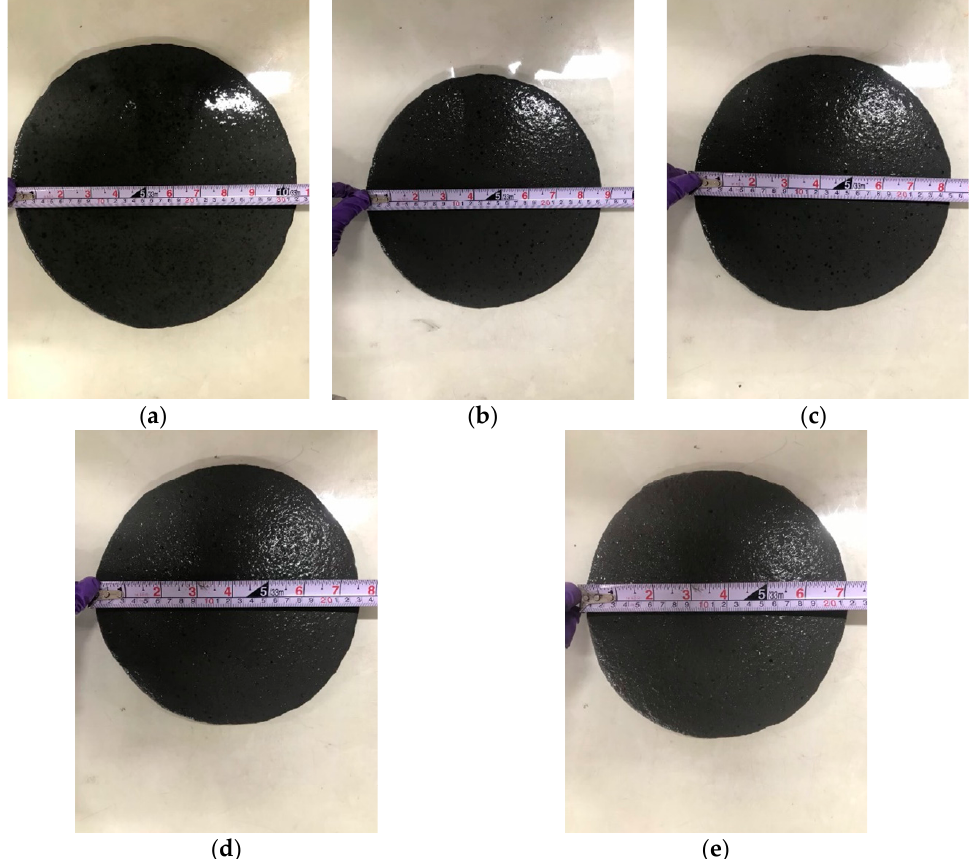
Figure 2. Photographs of slump-flow test results: ( a ) 0 min; ( b ) 15 min; ( c ) 30 min; ( d ) 45 min; ( e ) 60